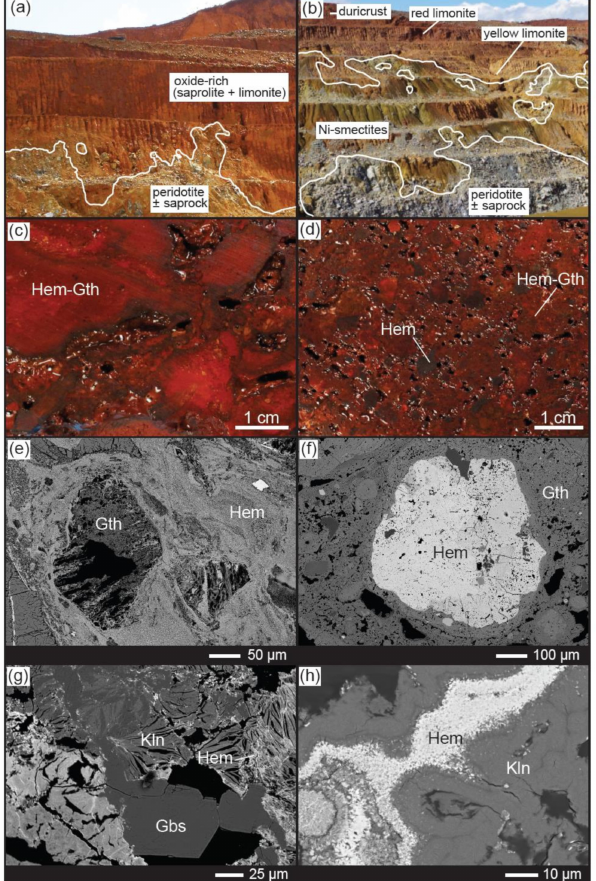
Figure 3. ( a ) Typical sharp transition from silicate-dominated bedrock and saprock to oxide- dominated saprolite and limonite (Ma-Oui). ( b ) Well-developed Ni smectite-rich zone (up to >15 m in vertical thickness) above lherzolitic serpentinite at East Alpha. ( c ) Vesicular hematite-goethite-bearing lateritic residuum (East Alpha). ( d ) Nodular/pisolitic ferricrete (East Alpha). ( e ) Recrystallisa- tion of goethite and hematite with local preservation of inherited textures at the microscopic scale in the lateritic residuum, East Alpha (BSE imaging). ( f ) Goethitic pisolitic cortexes overgrowing onto nodular hematite in a goethite-bearing cement, ferricrete horizon, East Alpha (BSE imaging). ( g , h ) Kaolinite-gibbsite-hematite mineral assemblage in saprolitised gabbro at East Alpha (BSE imag- ing). Mineral abbreviations: Gth = goethite, Hem = hematite, Kln = kaolinite, Gbs = gibbsite. Onset ( b ) is modified after